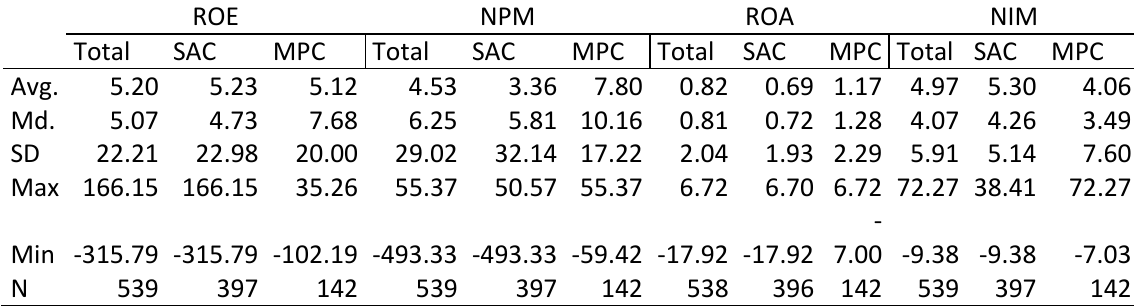
(Avg.=Arithmetic average, Md.=Median, SD=Standard deviation, Max=Maximum, Min=Minimum,